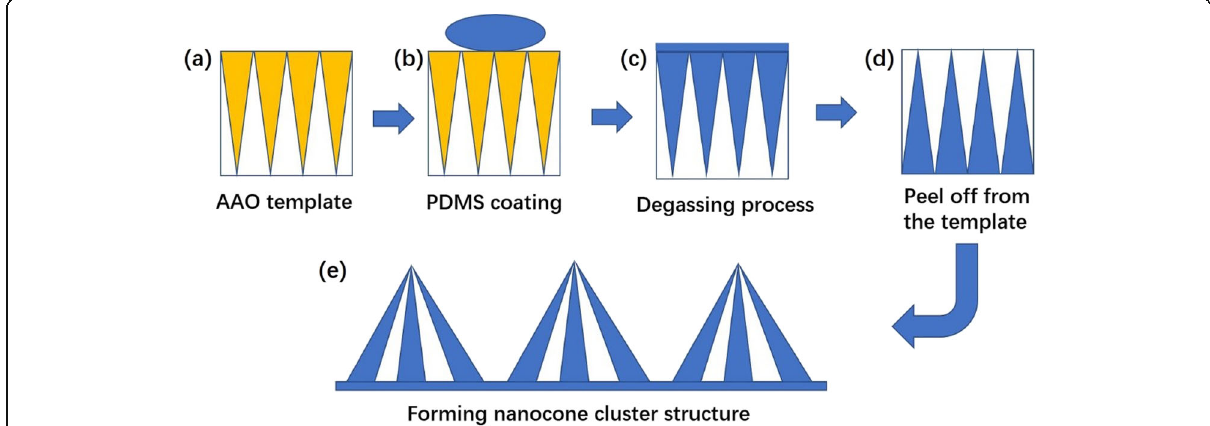
Fig. 1 a – e The schematic fabrication process of nanocone cluster